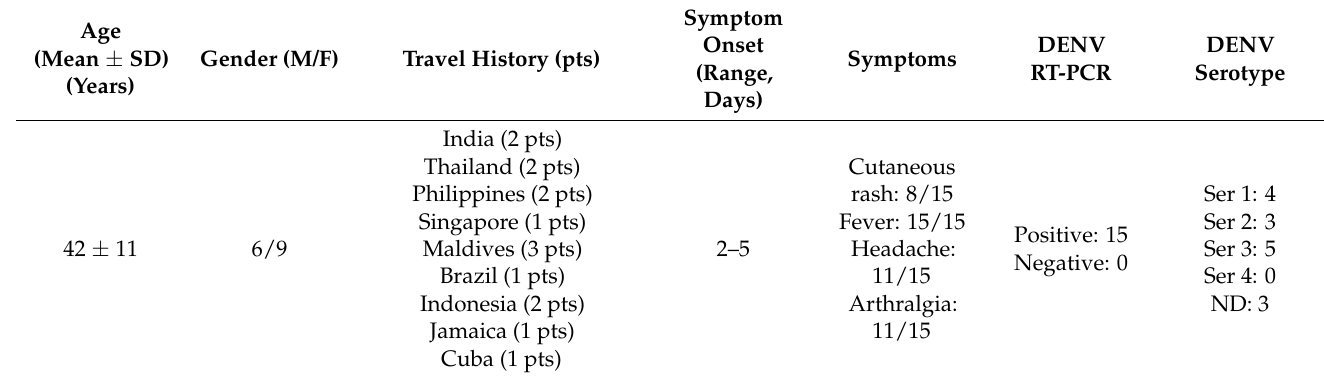
Table 1. Characteristics of 15 DENV patients included in the